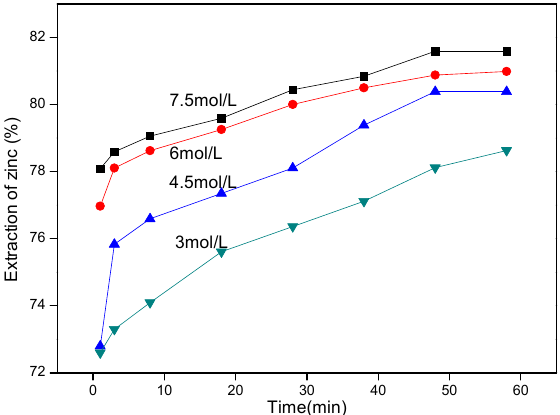
Figure 5. Effect of total ammonia concentration (ammonia/ammonium chloride = 1/2). Mass of solid 20 g, volume of solution 1000 mL, temperature 40 °C.